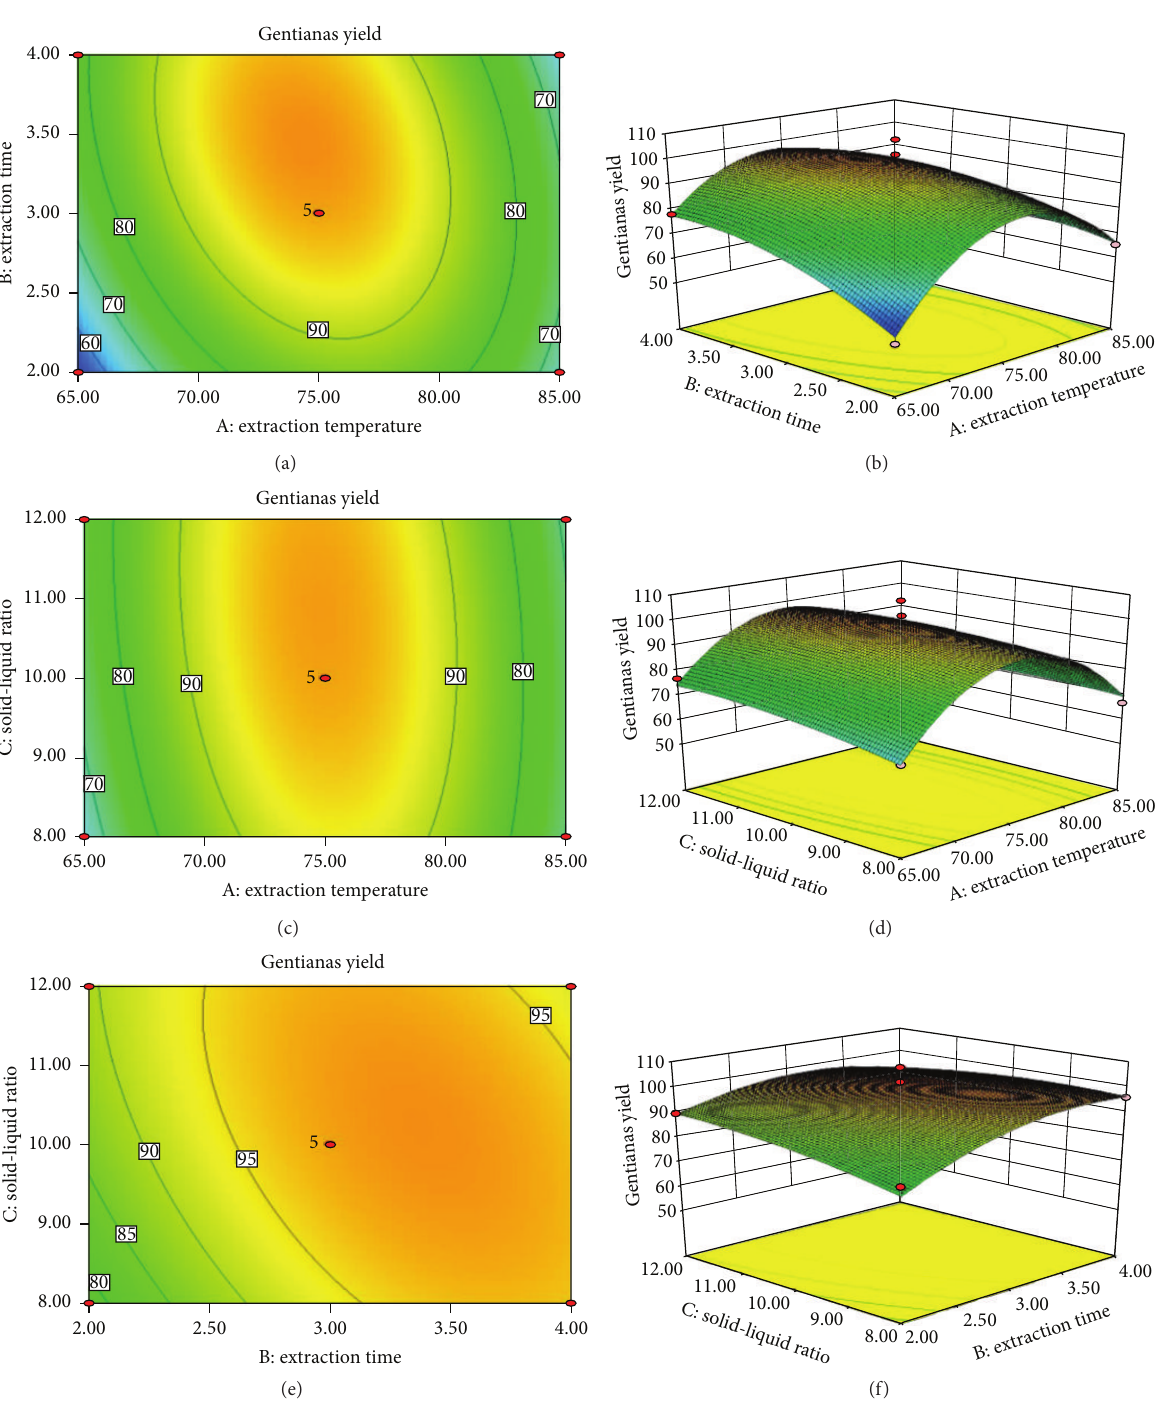
Figure 4: 2D contour plots and 3D response surface plots of the effects on relationships between independent variables and response value; ((a) and (b)) 2D contour and 3D plot of the interactions between extraction time and extraction temperature; ((c) and (d)) 2D contour and 3D plot of the interactions between extraction temperature and the ratio of liquid to material; ((e) and (f)) 2D contour and 3D plot of the interactions between extraction time and the ratio of liquid to